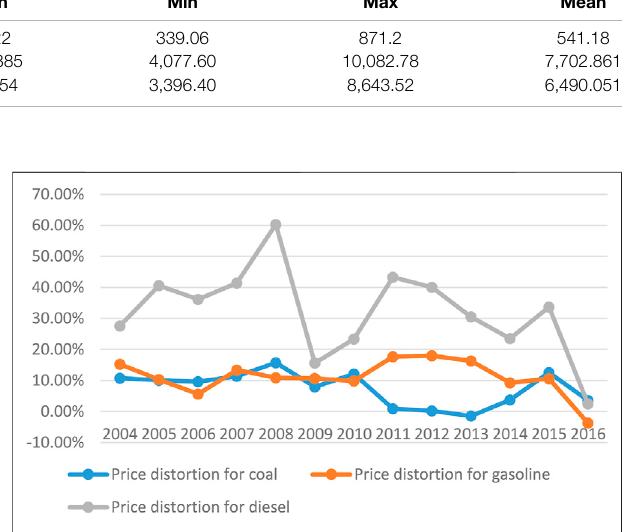
FIGURE 3 | The price distortion proportion of